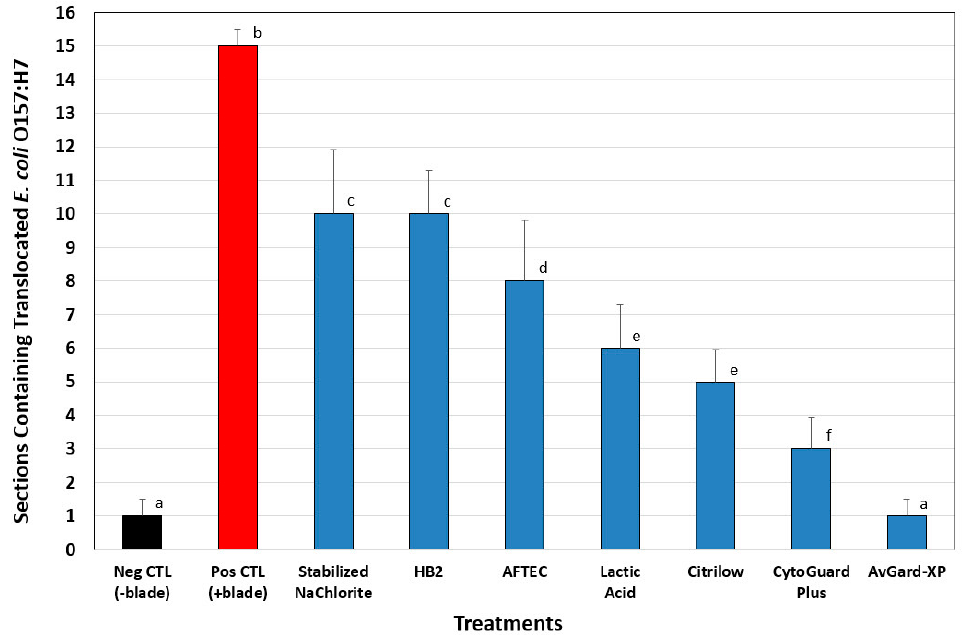
Figure 4. Reduction of E. coli O157:H7 in antimicrobial spray-treated, blade-tenderized beef as determined from individual core sections recovered after processing (i.e., inoculation, spray treatment, blade tenderization, core excised, sectioning, blending, enrichment, and microbial plating). Results for each treatment (four cores/treatment; four sections/core; n = 16 sections) were determined for the presence/absence of our inoculated E. coli 157:H7 strains. Negative controls represented inoculated but non-tenderized beef (Neg CTL), while positive controls represented inoculated and tenderized beef (Pos CTL). Positive and negative controls were sprayed with water instead of antimicrobials. Error bars represent standard deviation of E. coli O157:H7 presence (versus absence) within each set of the four replicate core samples, while bar height is the total of positive sections among four replications. Pairwise analysis of variance (Holm-Sidak method) of treatments with different letters represents significant differences ( p < 0.05); data bars with the same letters are not significantly different.